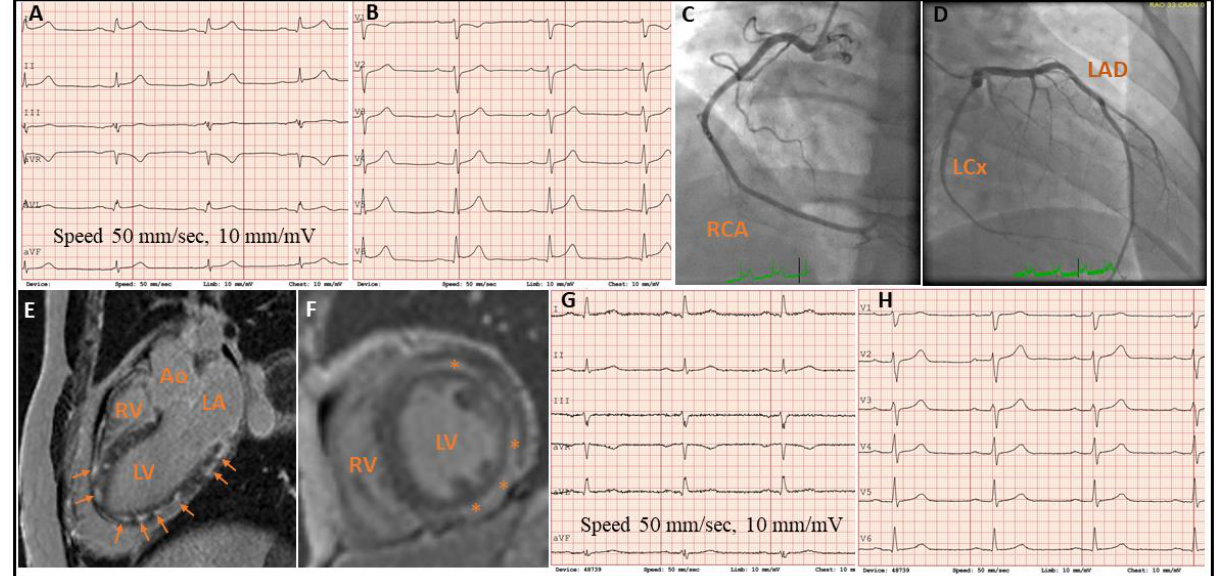
Figure 1. The electrocardiogram ( A , B ) on admission showing 1 mm ST-segment elevation in leads I, AVL and V5–V6, and 1 mm ST-segment depression in lead V1. Coronary angiography ( C , D ) shows normal RCA, LCx and LAD. The cardiac magnetic resonance images ( E , F ) demonstrate dispersed focal lesions with LGE in mid- and sub-epicardial myocardium (arrows and asterisks). The electrocardiogram at discharge ( G , H ) displays normalization of the ST-segments. Ao, aorta; LA, left atrium; LAD, left anterior descending artery; LCx, left circumflex artery; LGE, late gadolinium enhancement; LV, left ventricle; RCA, right coronary artery; RV, right ventricle.